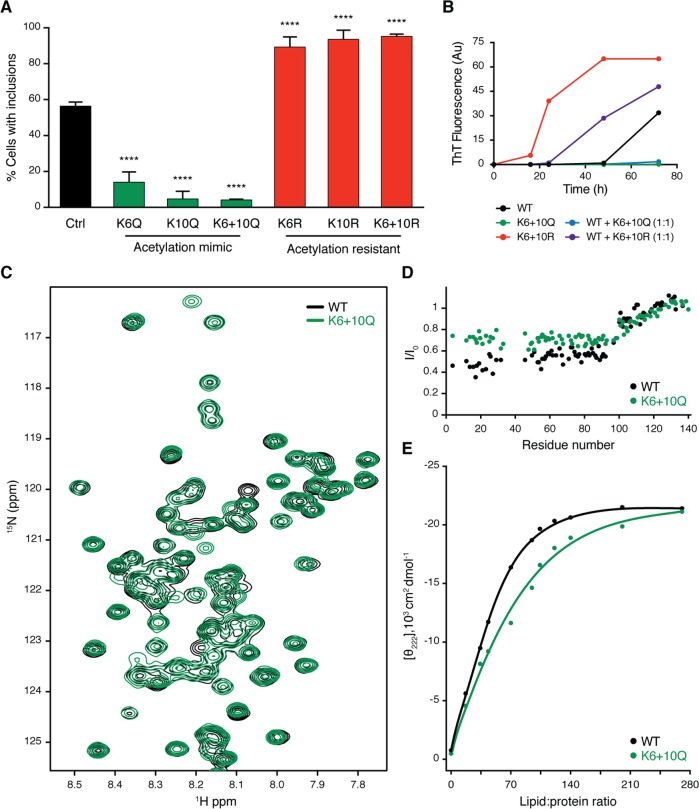
aSyn aggregation is modulated by acetylation.(A) H4 cells were cotransfected with WT, acetylation-resistant mutants (K6R, K10R, K6+10R), or acetylation-mimicking mutants (K6Q, K10Q, K6+10Q) of SynT together with synphilin-1. 48 h after transfection, cells were processed for ICC and the percentage of cells with inclusions was determined (n = 3). Data in panels are average ± SD, **** p < 0.0001, ordinary one-way ANOVA with Tukey’s multiple comparisons test. (B) Oligomerization kinetics of recombinant aSyn assessed by Thioflavin-T reaction. WT, K6+10Q, K6+10R, and a mixture of 1:1 of WT with K6+10Q or K6+10R were evaluated. (C) Superposition of 2D 1H-15N HSQC nuclear magnetic resonance (NMR) spectra of recombinant 15N-labelled aSyn WT (black), K6+10Q (green). (D) Residue-specific changes in 1H-15N HSQC signal intensities of aSyn WT (black) and aSyn K6+10Q (green) upon addition of small unilamellar vesicles (SUVs) formed by POPC:POPA (1:1 molar ratio). The aSyn-to-lipid molar ratio was 1:100. (E) Estimation of the binding affinity of aSyn to POPC:POPA SUVs from circular dichroism. Variations in absorption at 222 nm are plotted as a function of lipid:protein molar ratio. Calculated affinities are 57 ± 13 and 71 ± 16 μM for aSyn WT (black) and aSyn K6+10Q (green), respectively. Data in S1 Data.